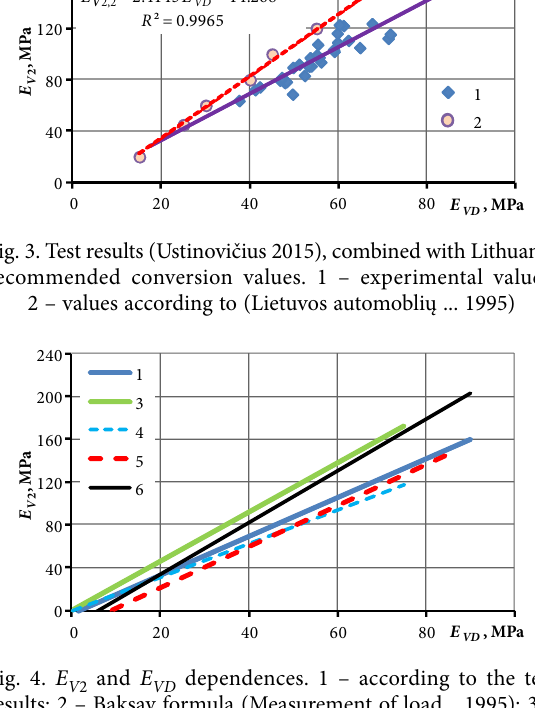
and E dependences. 1 – according to the test Fig. 4. E V 2 VD results; 2 – Baksay formula (Measurement of load... 1995); 3 – coarse and fine soils, (Tompa 2008), 4 – Zorn instruments 2004; 5 - Lietuvos automobilių ...